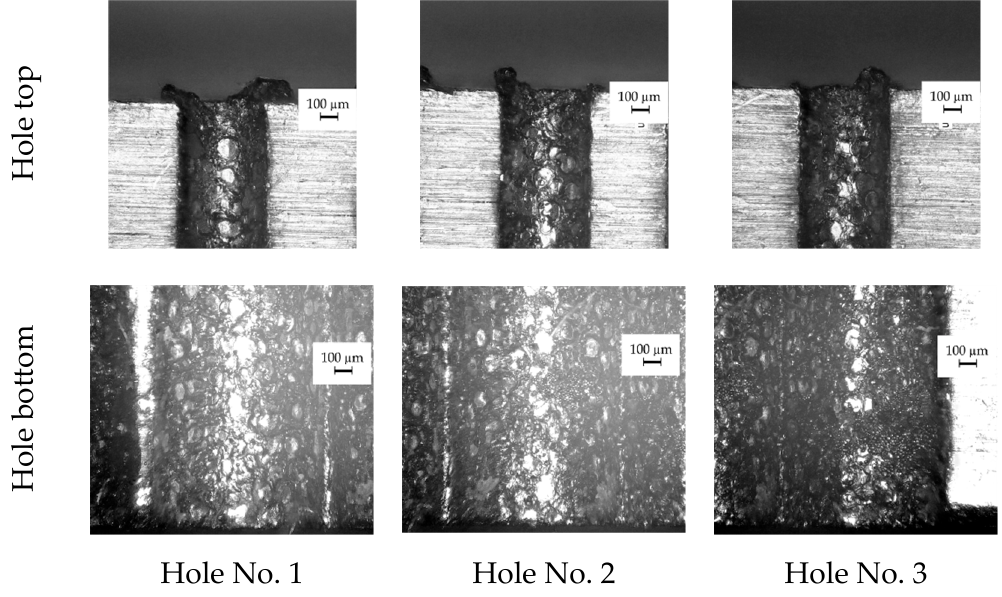
Figure 11. Images of the longitudinal section of three through holes at the hole top and bottom.